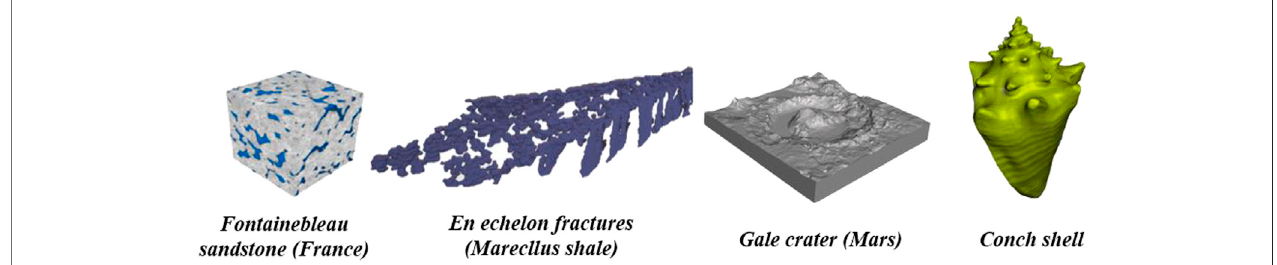
FIGURE 5 | An example of the module instructions from the course e-book. The full version of the e-book was available for participants a day before the course. Each module contained synopsis and a set of exercises.